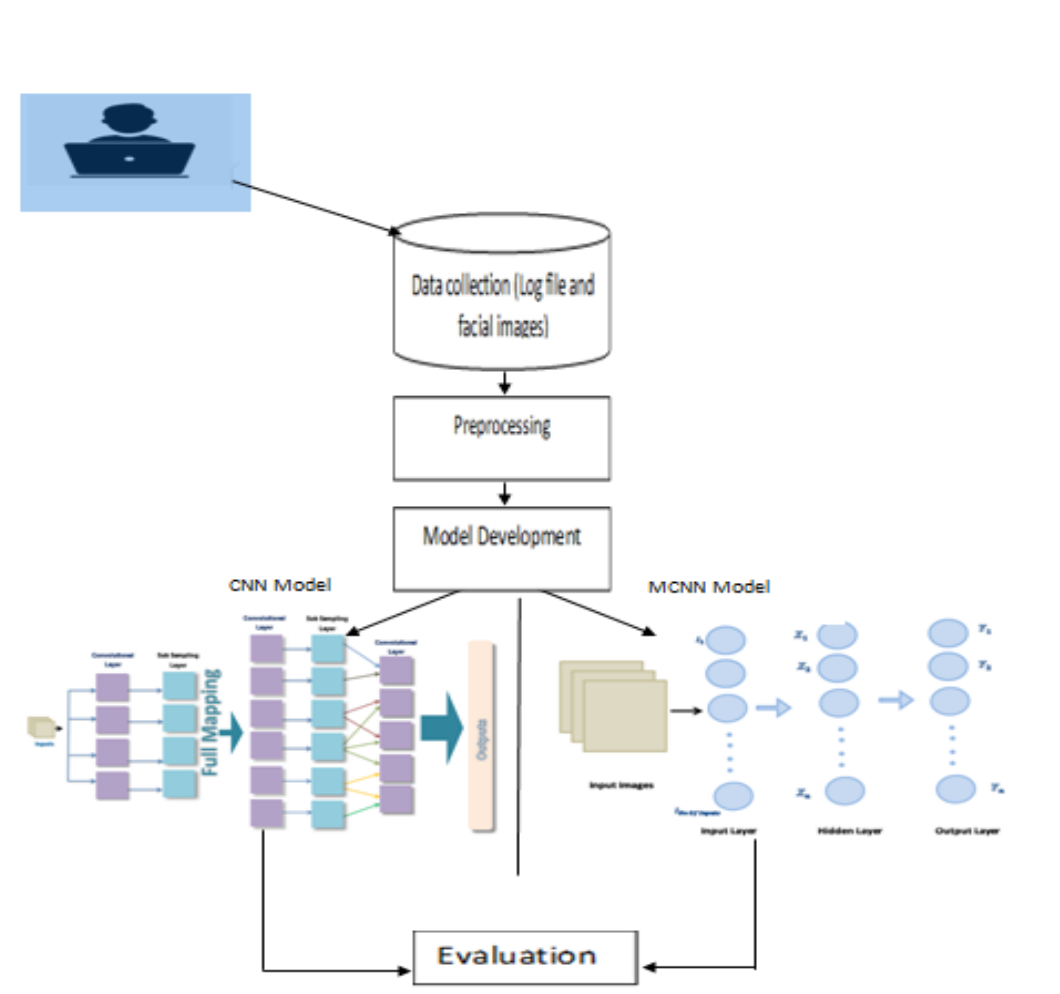
Figure 4. Framework for the proposed model